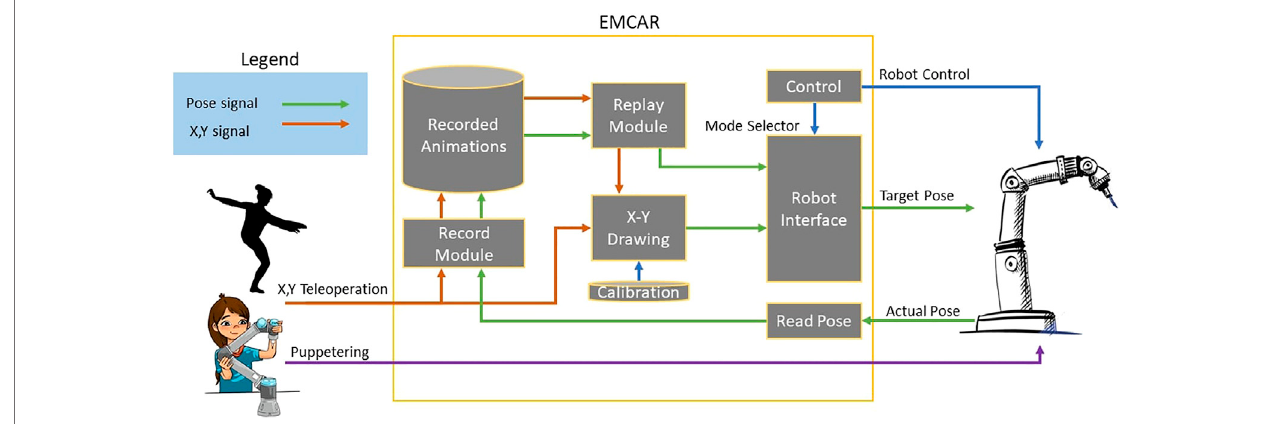
FIGURE2| DiagramofinternalfunctionsofEMCAR.Intheleftarethedifferentinputs,X-YpositionandPuppeteering.Intherightistherobotinterface.Inthemiddle, inside of the orange square is the internal modules of EMCAR that create its functionalities.